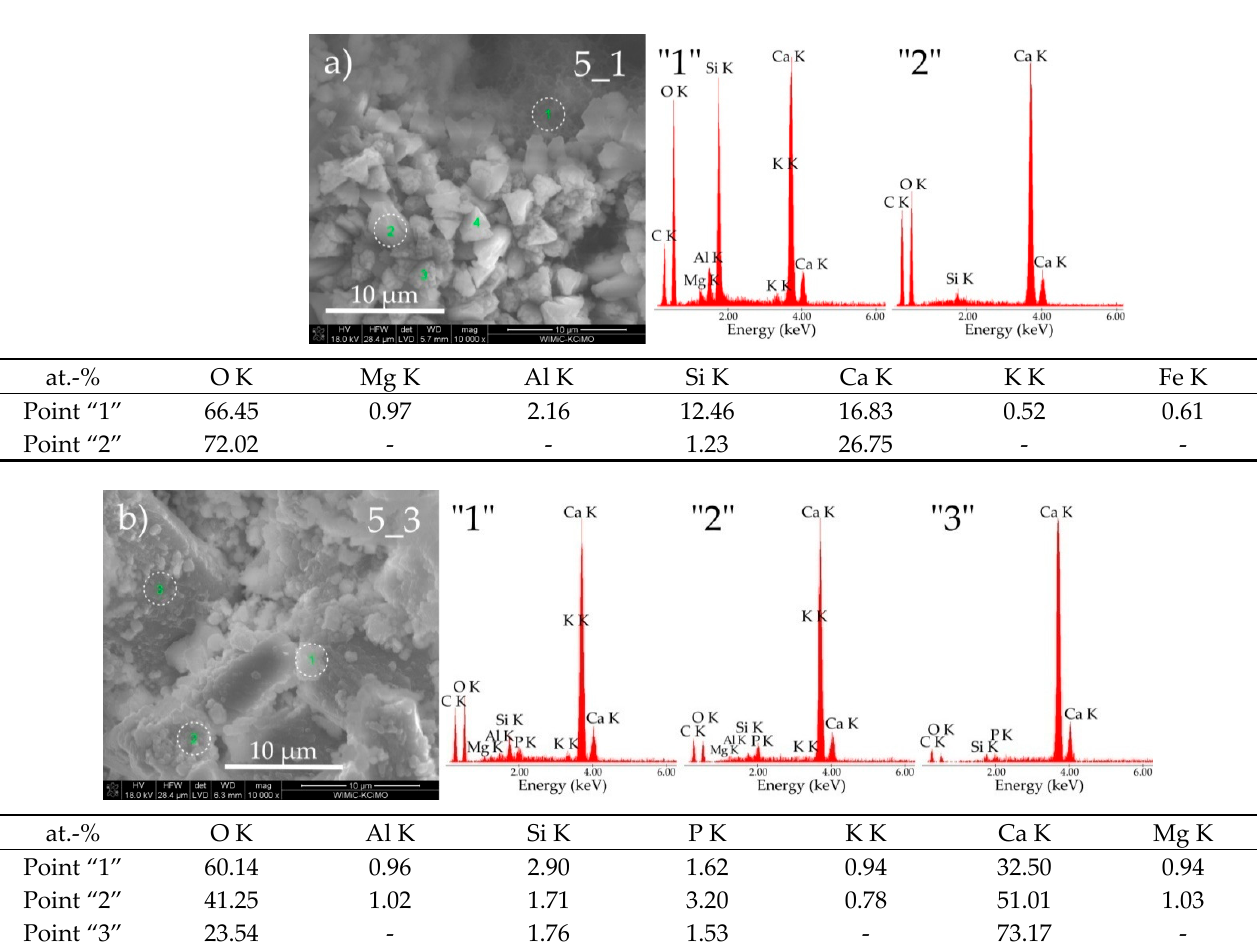
Figure 7. SEM micrographs of cement paste 5 obtained after exposure under the conditions of ( a ) water (sample 5_1) and ( b ) pig slurry (sample 5_3) with EDS quantitative point analyses from areas 1, 2, and 3.